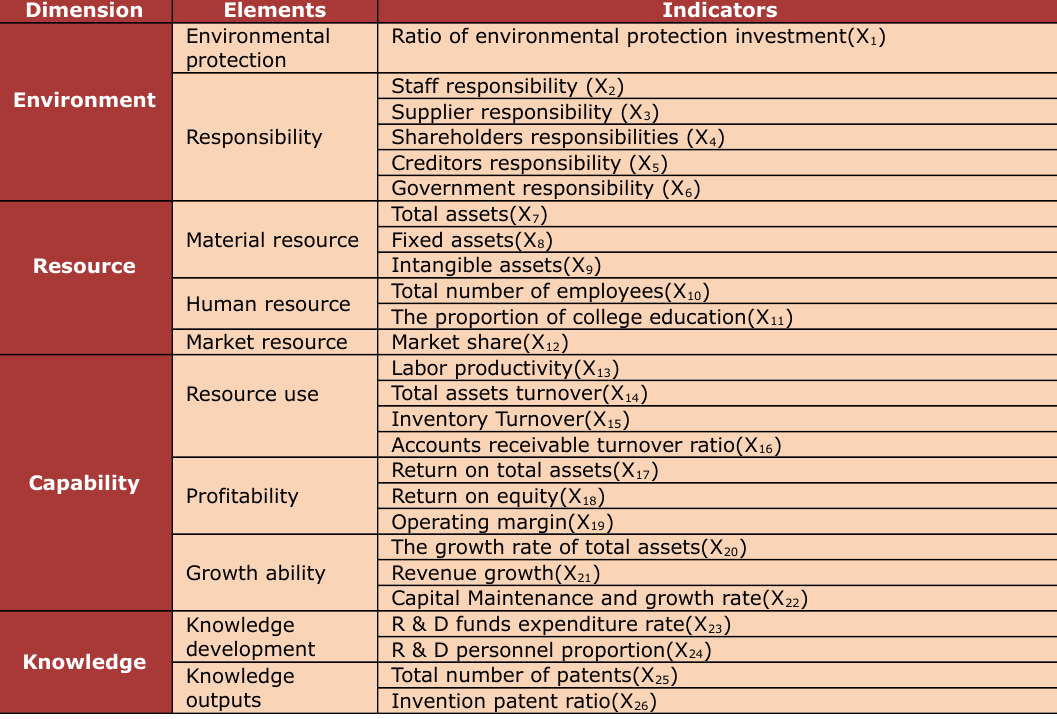
Table 1. Evaluation indicator system on green competitiveness of China Automotive enterprises